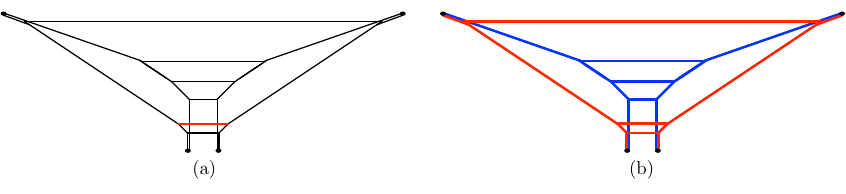
Figure 2 . (a) A Higgsing of SU(6) 3 +1 TAS into two SU(3) 3 theories by aligning internal D5-branes in red. (a) Two di(cid:11)erent SU(3) 3 theories are painted in blue and red,